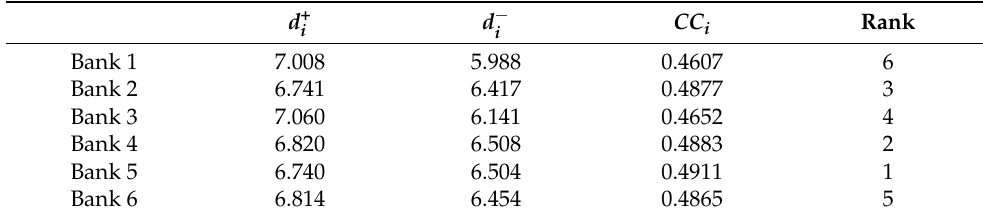
Table 7 below presents the wealth management bank assessment. Table 7. Closeness coefficients and